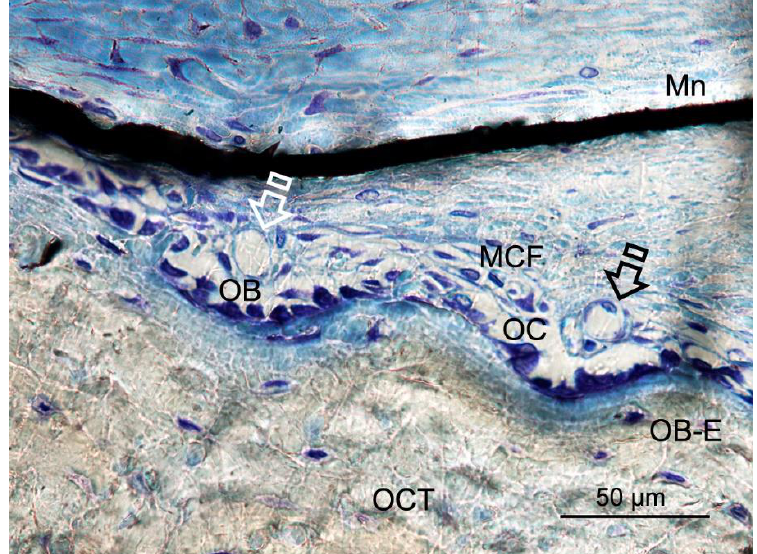
Figure 6. Bone histology images obtained after using Zn-HOOC-Si loaded membrane ( Mn ), by dye with toluidine blue to visualize mineralized bone, at six weeks of healing time. Single arrows point the presence of blood vessels; both osteoblasts and osteoclasts are in close contact with marrow elements and the contiguous vasculature. Osteocytes ( OCT ), osteoblasts ( OB ), entrapped osteoblasts ( OB-E ), osteoclasts ( OC ) and macrophages ( MCF ) may be observed.